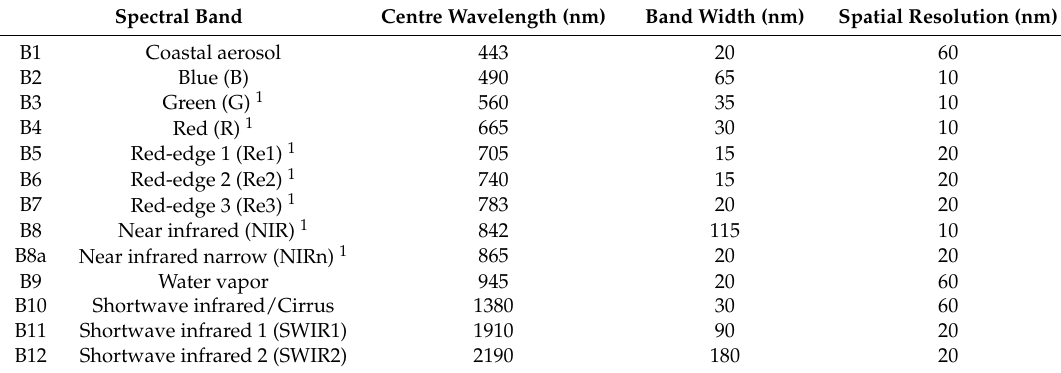
Table 1. The spectral bands and resolutions of Sentinel-2 MSI